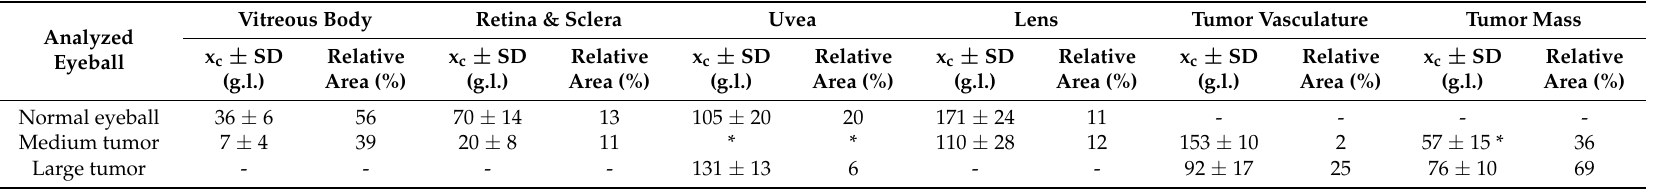
Table 1. Parameters of the Gauss functions fitted to gray-level histograms of the representative hamster eyes without melanoma, with a medium-sized tumor, and with a large tumor. The results are expressed as the mean values ± Standard Deviation. Relative area was calculated as a ratio of corresponding peak area to total area. * (asterisks) indicate that medium tumor mass includes mass of identically stained uvea. The same eyeballs are shown in Figure